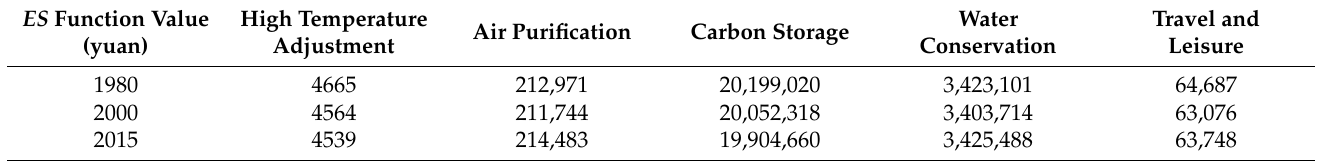
Figure 5. Spatial distribution of ecological service value of land system in Xi’an from 1980 to 2015 (1 km × 1 km). Table 5. Functional value of Land system Ecological Service in Xi’an from 1980 to 2015 (yuan).